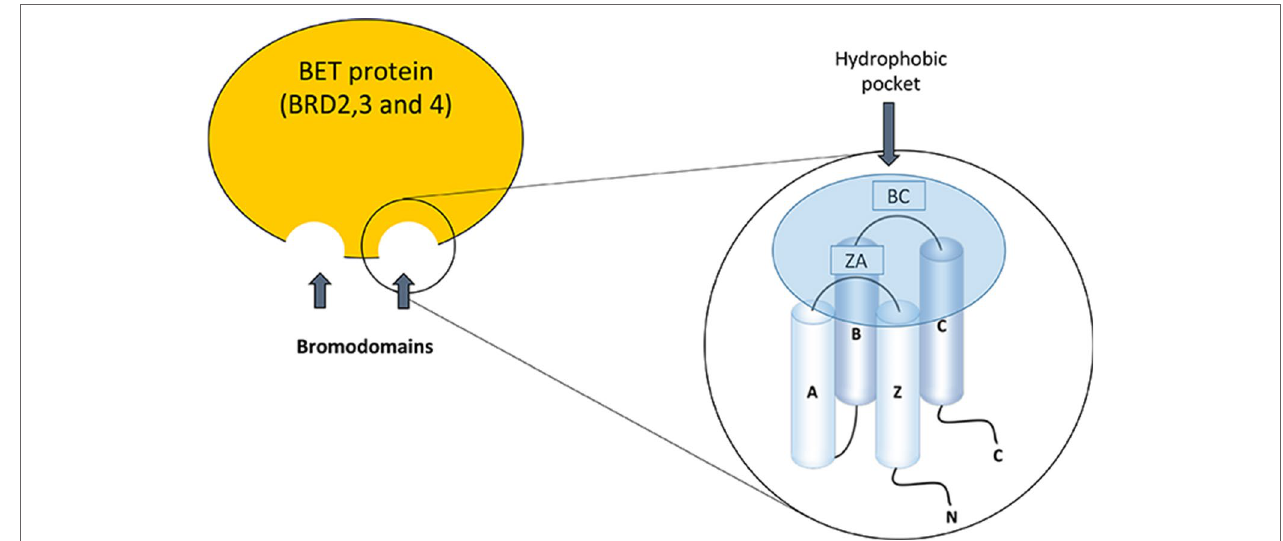
FIGURE 1 | Bromodomain structure in the bromodomain and extraterminal (BET) family proteins.